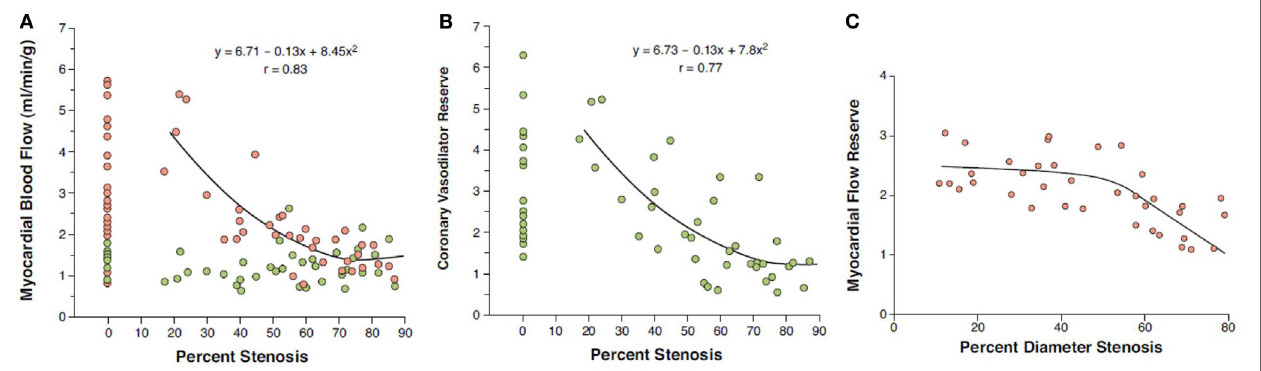
FiGURe 1 | Coronary flow in relation to epicardial artery diameter stenosis (%). (A) At rest, no relationship between myocardial blood flow (MBF) and percentage coronary artery stenosis is noted (green circles), while there is an inverse relationship between hyperemic MBFs and percentage of focal epicardial narrowing during pharmacologic vasodilation (red circles). (B) Likewise, myocardial flow reserve (MFR = hyperemic MBF/resting MBF) demonstrates a comparable inverse relationship with percentage coronary artery stenosis (41). Yet, when analyzing stenoses of intermediate severity (40–70% diameter stenosis), a relatively high variability in individual MFR is realized. Of note, diminished hyperemic MBF or MFR in individuals without epicardial coronary artery stenoses may be comparable to those in myocardial regions subtended to epicardial lesions ≥ 50% diameter stenosis. (C) MFR commonly decreases when percent diameter stenosis exceeds ≥ 50% as measured with quantitative coronary angiography (correlation coefficient r = 0.77, root mean square error = 0.37, p < 0.00001) (41) [reproduced with kind permission from Schindler et al.